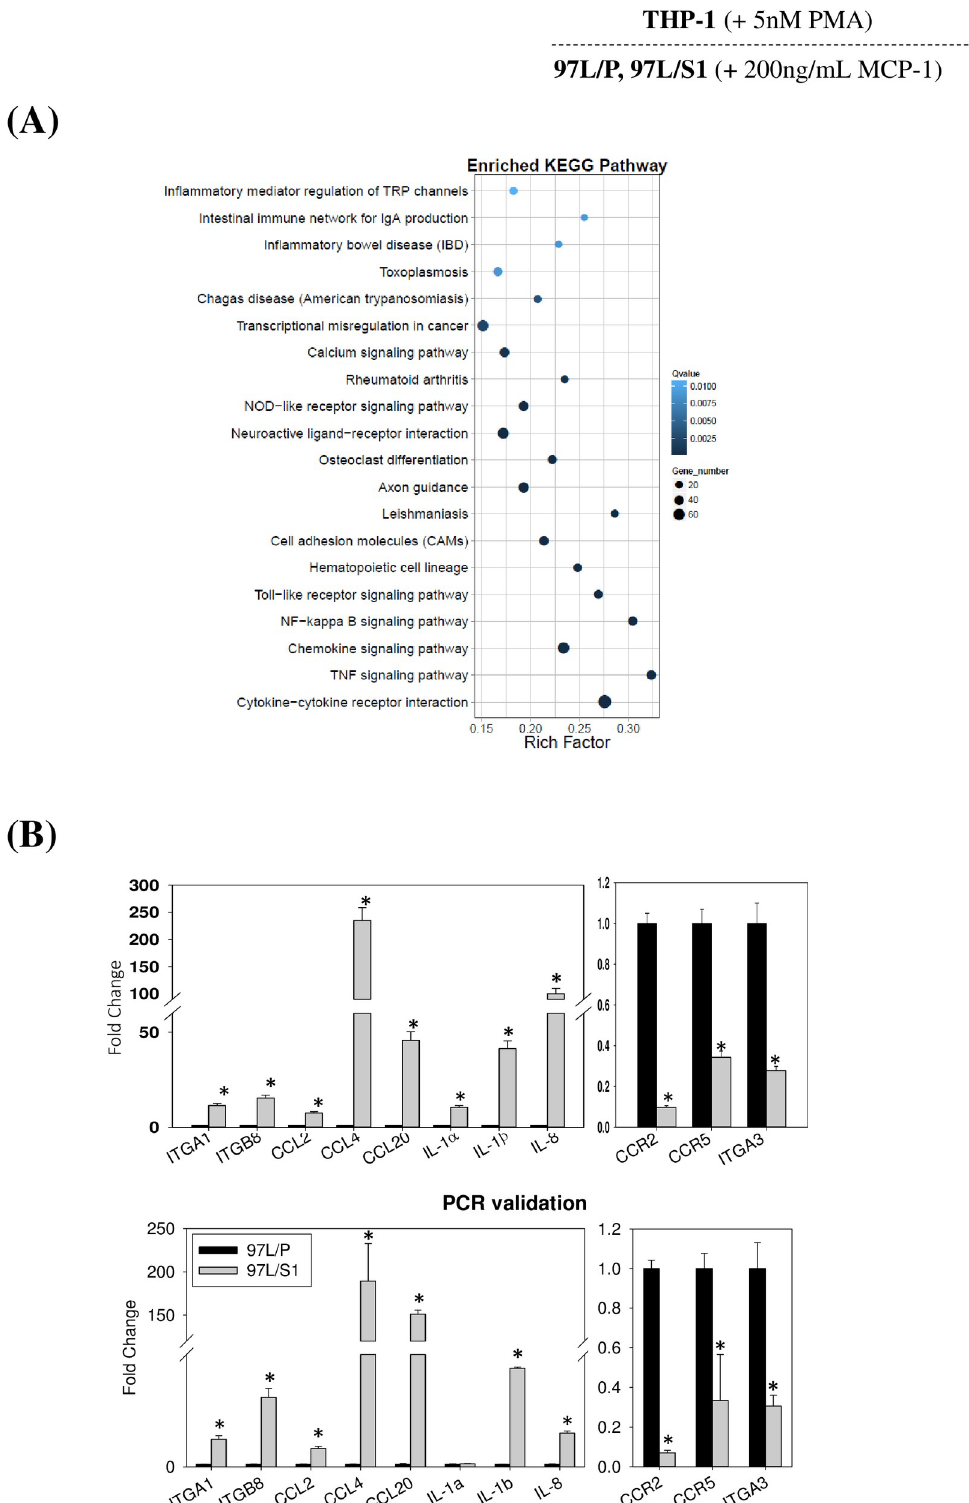
Fig 3. Transcriptomic analysis of THP-1 in MHCC97L co-culture. PMA (5 nM) treated THP1 cells was co-cultured with either MHCC97L/S1 or MHCC97L/P for 24 hr. Total RNA of THP-1 cells were extracted for transcriptome. (A) An enriched KEGG pathway. X and Y-axes represent the rich factor and pathways, respectively. The rich-factor refers to the